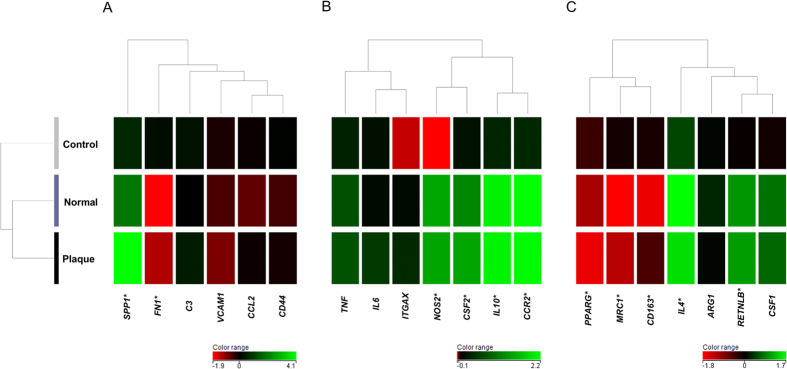
Microarray analysis of renal papillary tissue from calcium oxalate (CaOx) stone formers and control patients.Normal papillary tissues of non-stone patient were used as the control group. Normal papillary tissues and papillary tissues with Randall’s plaque of CaOx stone formers were used as normal and plaque groups, respectively. Cluster analysis of genes was performed among the three groups. Statistical comparisons of gene expression signals were implemented between the control and normal/plaque groups. *Indicates significant differences at p < 0.01 or >2-fold changes. (A) Crystal-related genes. (B) M1Mφ-related genes. (C) M2φ-related genes.